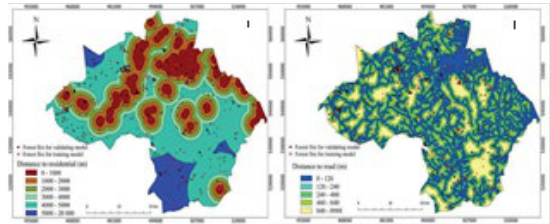
Figure. 4. Fire conditioning factors (i. Distance to Residential;